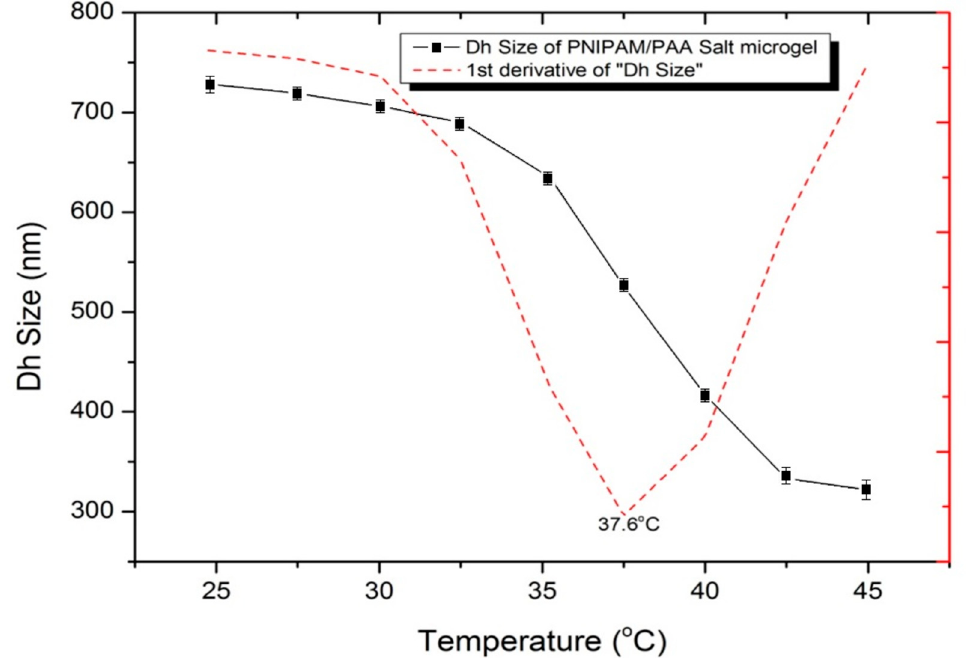
Figure 8. Size (D h —hydrodynamic diameter) of the microgel PNIPAM/PAA salt, as a function of temperature through DLS. The suspension pH was equal to 7.4. The red dash line underlines the VPTT, which corresponds to 37.6 °C. The data represent means ± standard deviation from three experiments.